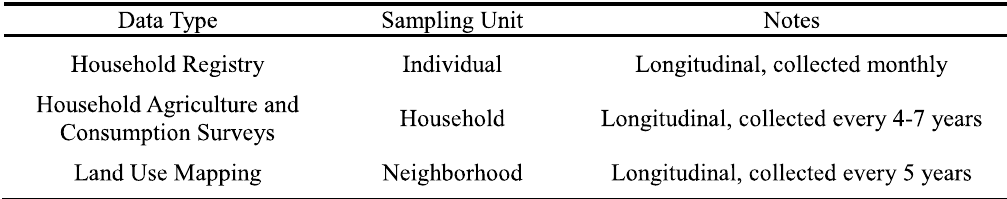
Table A2.1: Time scales of data collection for the three key CVFS datasets used to parameterize the Chitwan